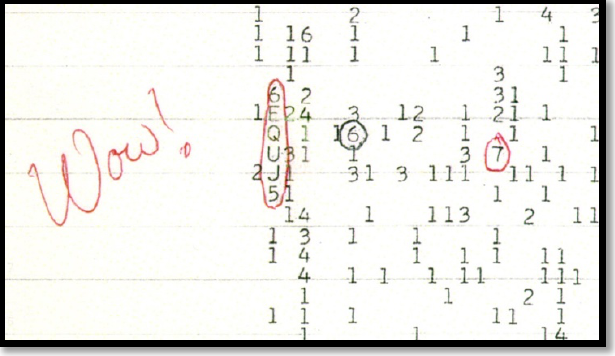
Fig. 2 . The original printout with Jerry Ehman's handwritten exclamation of The Wow! Signal represented as "6EQUJ5".